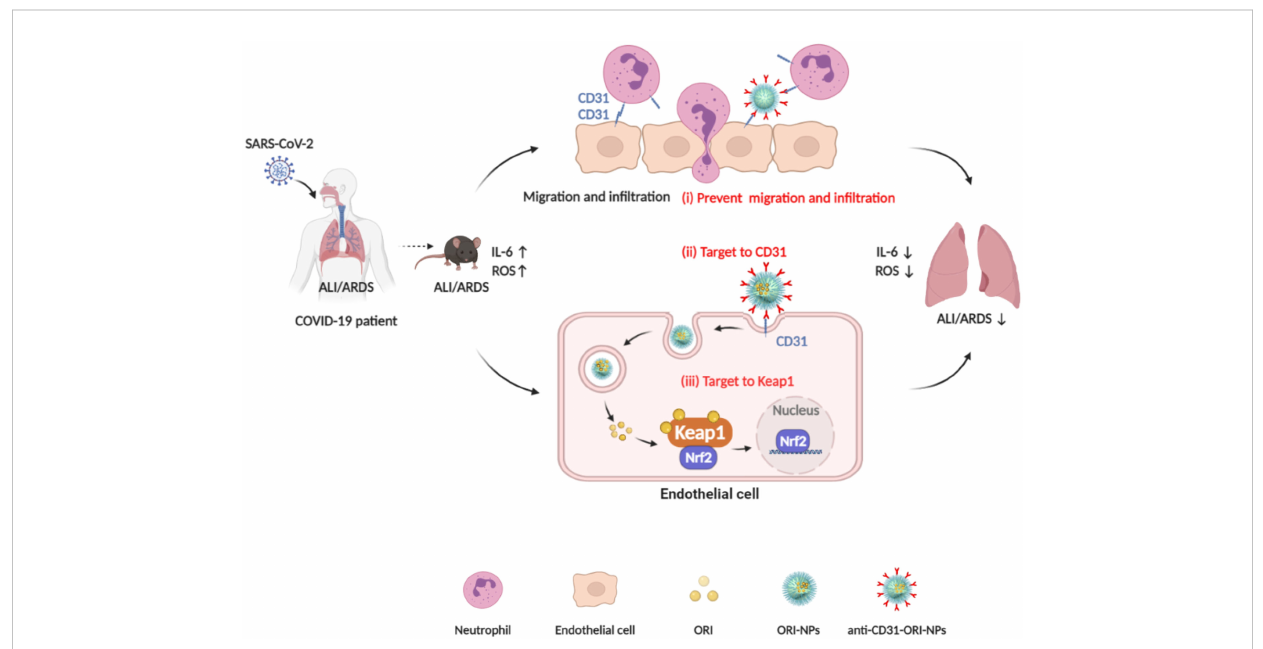
FIGURE 7 The mechanism of anti-CD31-ORI-NPs to ameliorate ALI/ARDS. (i), anti-CD31-ORI-NPs prevent neutrophil migration and in fi ltration via interruption of CD31-CD31 bond. (ii), anti-CD31-NPs speci fi cally target to endothelial cell via CD31 for ORI release to inhibit ROS and IL-6 expression via (iii), binding to